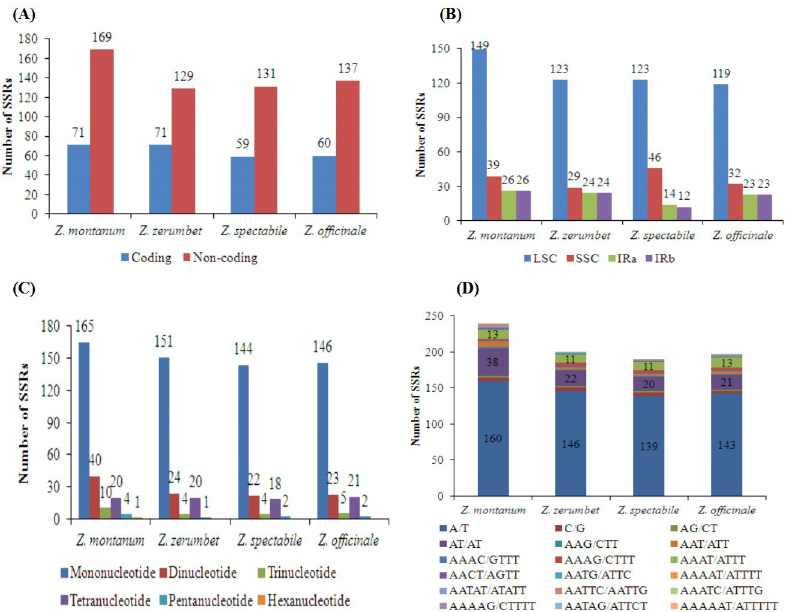
Fig 5. Comparison of simple sequence repeats among four chloroplast genomes of Zingiber species. (A) SSRs distribution between coding and noncoding regions detected in the four Zingiber species chloroplast genomes. (B) Frequencies of identified SSRs in LSC, SSC and IR regions. (C) Number of different SSR types detected in four Zingiber species chloroplast genomes. (D) Frequency of identified SSRs in different repeat class types.